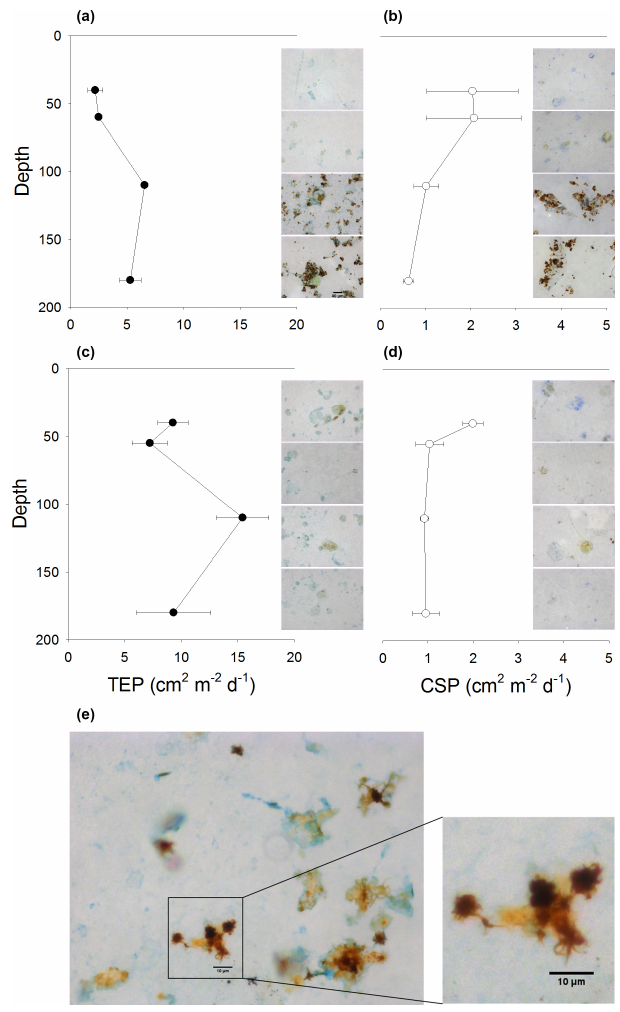
Figure 6. TEP and CSP fluxes in GB (a, b) and LD (c, d) . In ad- dition to vertical fluxes, each profile is complemented with micro- scopic images (200 × ) of material collected at each depth. In GB, star-shaped MnOx-like particles are clearly visible as single parti- cles and forming aggregates with TEPs (a) and CSPs (b) . MnOx- like particles were less abundant in LD (c, d) . (f) A larger magnifi- cation (400 × ) image of MnOx-like particles at 110m showing more detail on the shape of particles and aggregates formed with